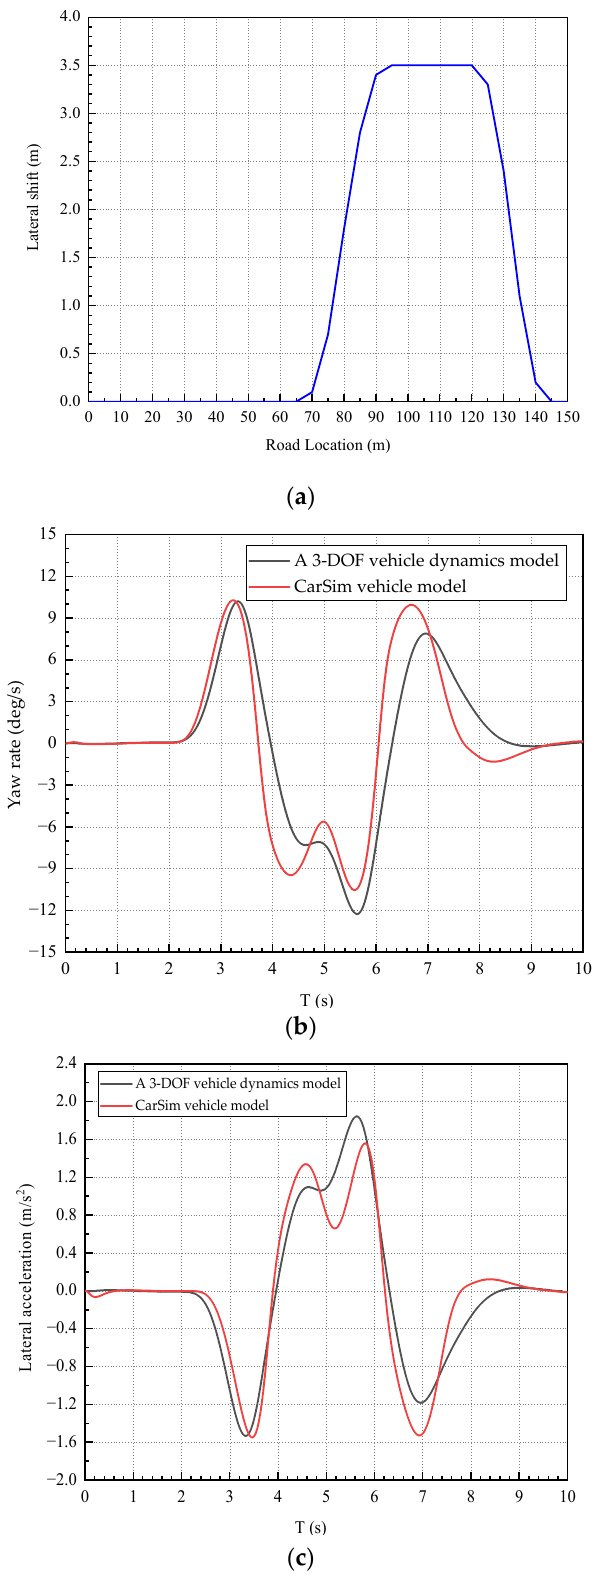
Figure 3. Response curve of double shifting line: ( a ) road offset routes; ( b ) yaw rate; and ( c ) lateral acceleration.